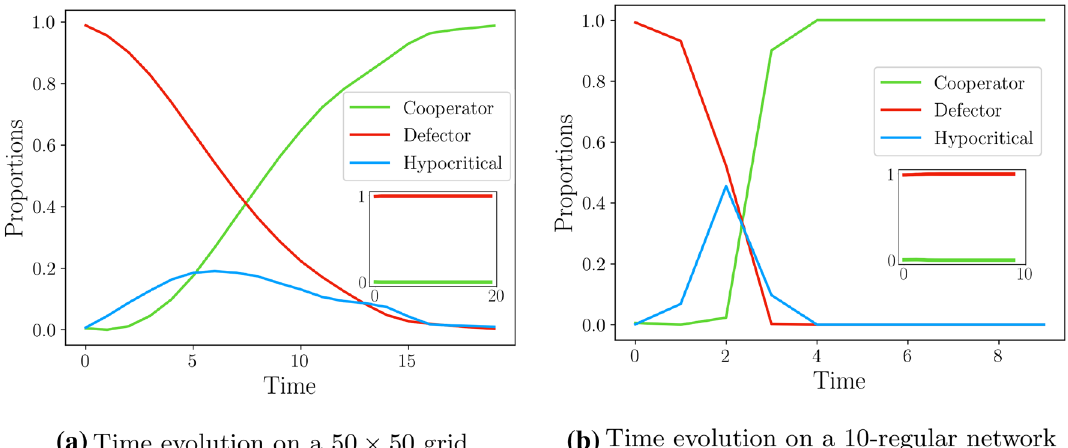
Figure 2. Evolution of cooperation in grids and random 10-regular networks. (a) Corresponds to a 50 × 50 grid network, and ( b ) corresponds to a random 10-regular network with 1000 vertices. Both simulations start with a configuration in which 99% of players are defectors. ( a ) and ( b ) show how the population